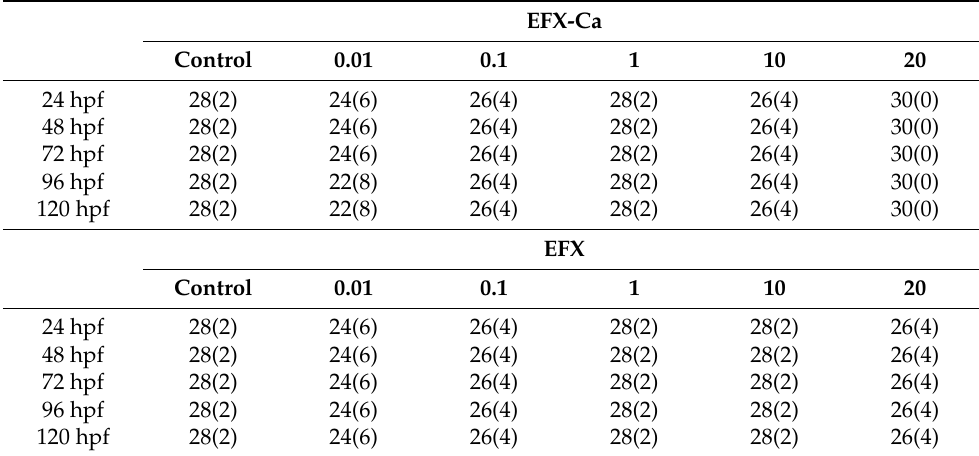
Table 6. The statistical survival (death) of the tested zebrafish under the medicated bath of different concentrations (0.01, 0.1, 1, 10, 20 µ M) of EFX-Ca or